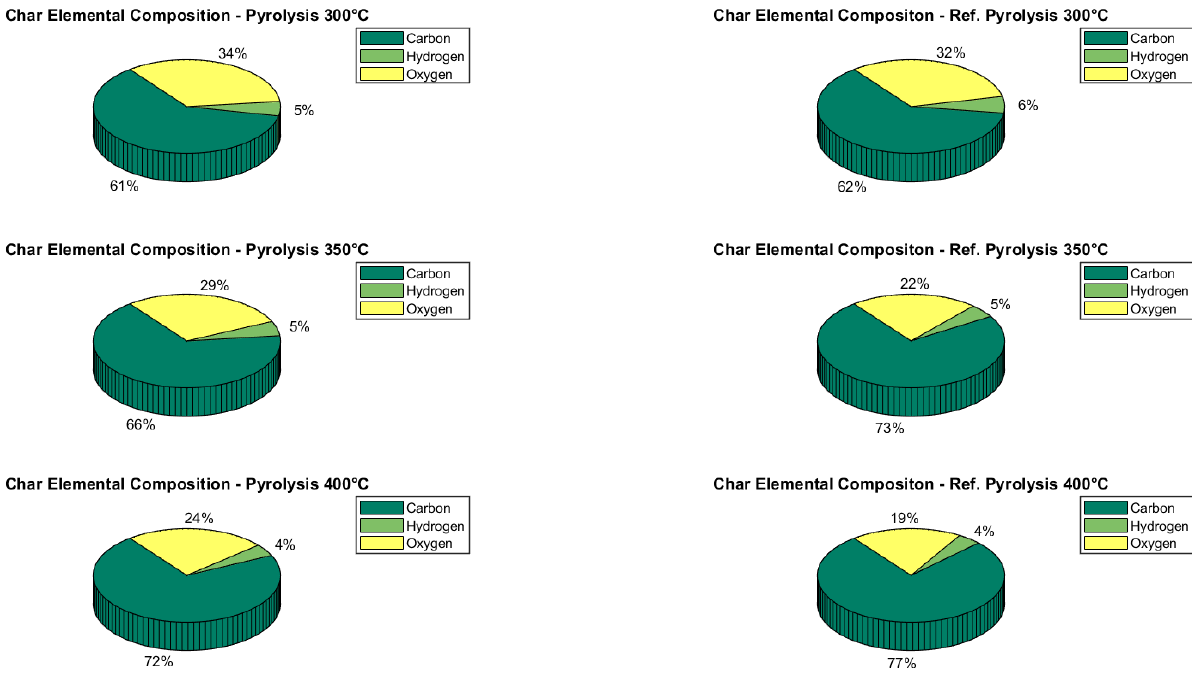
Figure 3. Validation of char elemental composition with variations in pyrolysis temperature. Validation by [35].